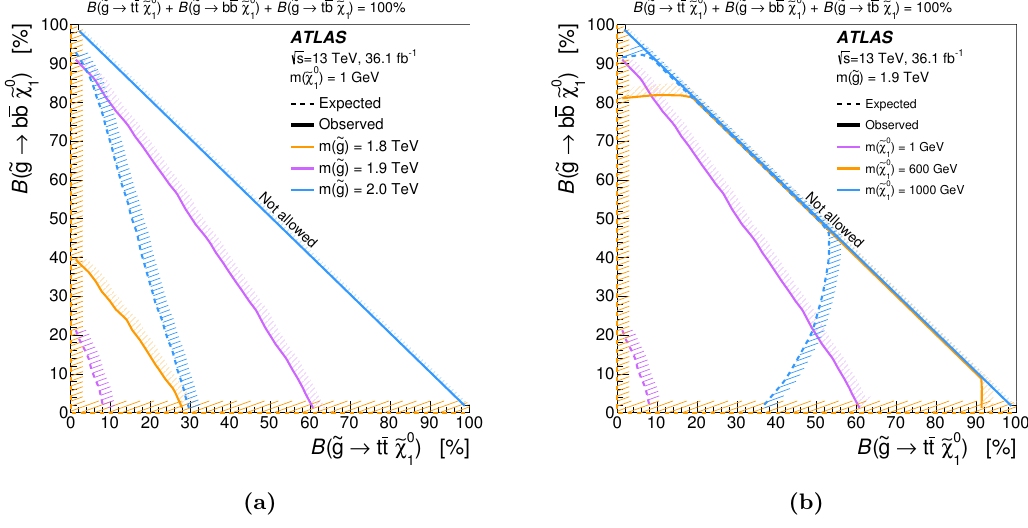
Figure 11. Exclusion limits in the ~ g ! t (cid:22) t ~ (cid:31) 0 1 and ~ g ! b (cid:22) b ~ (cid:31) 0 1 branching ratio plane assuming (a) a neutralino mass of 1 GeV and various gluino masses (1.8, 1.9 and 2.0 TeV) and (b) a gluino mass of 1.9 TeV and three neutralino masses (1, 600 and 1000 GeV). In (a), the expected limit for a gluino mass of 1.8 TeV follows the plot axes, meaning that the whole plane is expected to be excluded at 95% CL. The same is true in (b) for a neutralino mass of 600 GeV. The dashed and solid bold lines show the 95% CL expected and observed limits, respectively. The hashing indicates which side of the line is excluded. The upper right half of the plane is forbidden by the requirement that the sum of branching ratios does not exceed